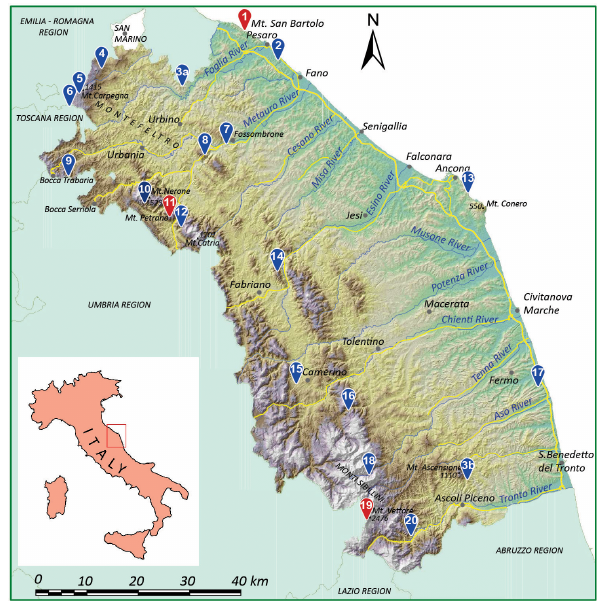
Figure 1. Digital elevation model of the Marche region with the sites involved in the project. The three case studies analysed in this paper are shown in red. © 2020 Marche region.